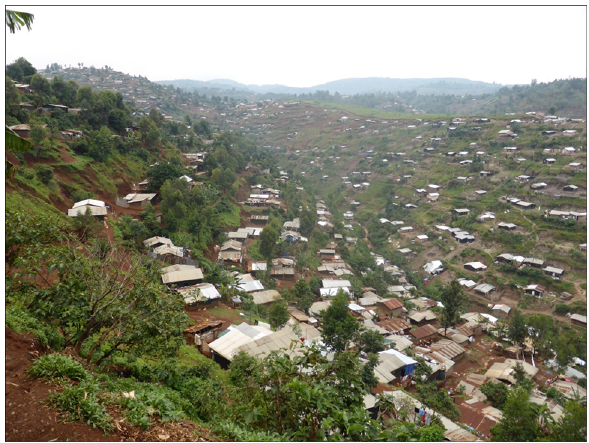
Fig. 8 Densely populated area in the Wesha River basin, Kivu Province. Houses are built on terraces dug into slopes prone to landslides (Photograph taken by Olivier Dewitte, June